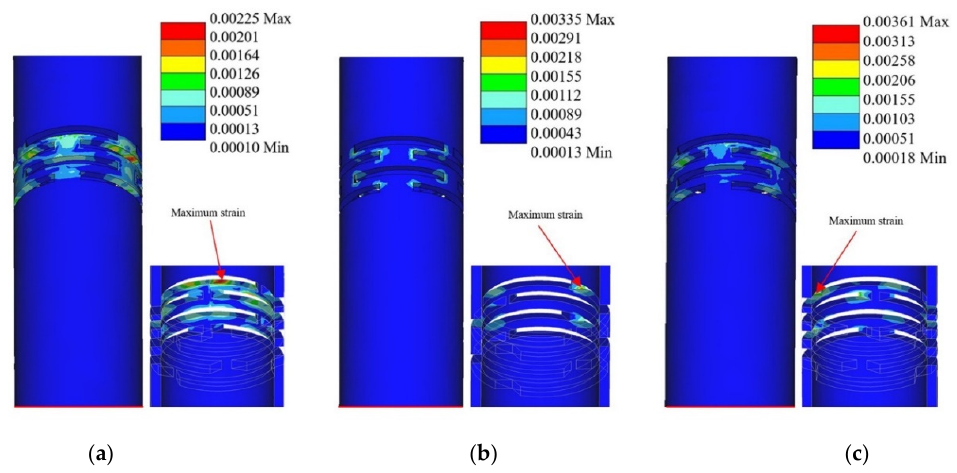
Figure 5. Strain contours of force sensor. ( a ) 8 N in the axial direction; ( b ) 8 N in the x-direction; ( c ) 8 N in the y-direction.